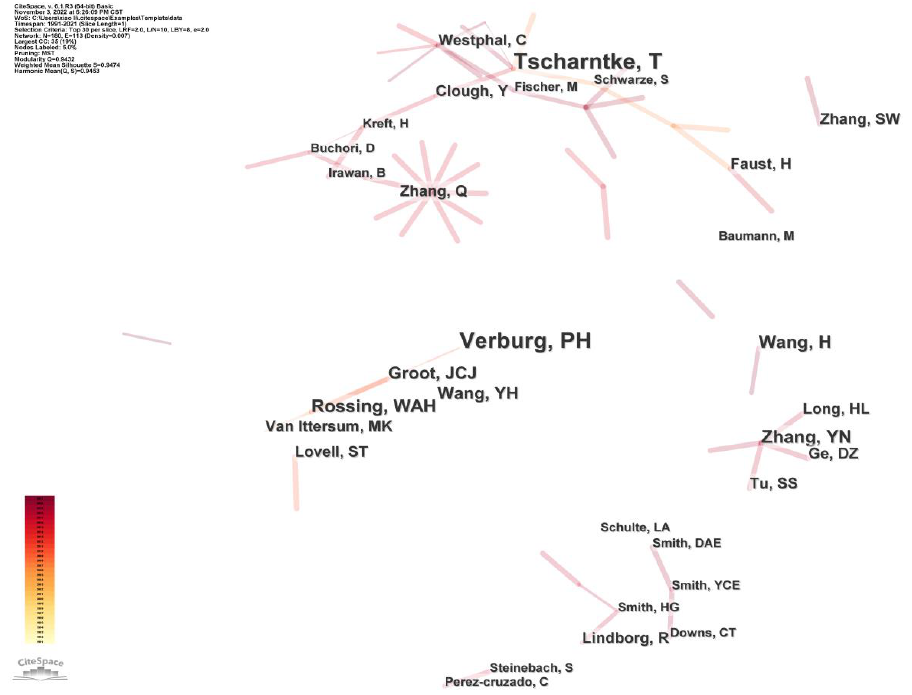
Figure 1. Co-occurrence network of top 30 authors with publications (the legend represents the color display for each year from 1991 to 2021). The visual knowledge map of the research institution used Citespace6.1.R3 software (Figure 2). The node represents the number of publications of institutions in Figure 2. The larger the node, the more publications it has. Therefore, institutions with a large number of publications in the field of agricultural land function include Chinese Acad Sci, Univ Chinese Acad Sci, Univ Gottingen, Wageningen Univ, INRA, Univ Copenhagen, Swedish Univ Agr Sci, UFZ Helmholtz Ctr Environm Res, Humboldt Univ, and Beijing Normal Univ. According to the statistical results, between 1991 and 2021, these institutions pub- lished 77, 36, 34, 33, 32, 30, 24, 21, 19, and 18 papers, respectively. The red nodes represent the citation bursts of institutions, that is, the institutions with the highest citation bursts are INRA, Univ Wageningen & Res Ctr, and AgroParisTech, whose outbreak periods are 2005 – 2014, 2005 – 2012, and 2009 – 2016, respectively.